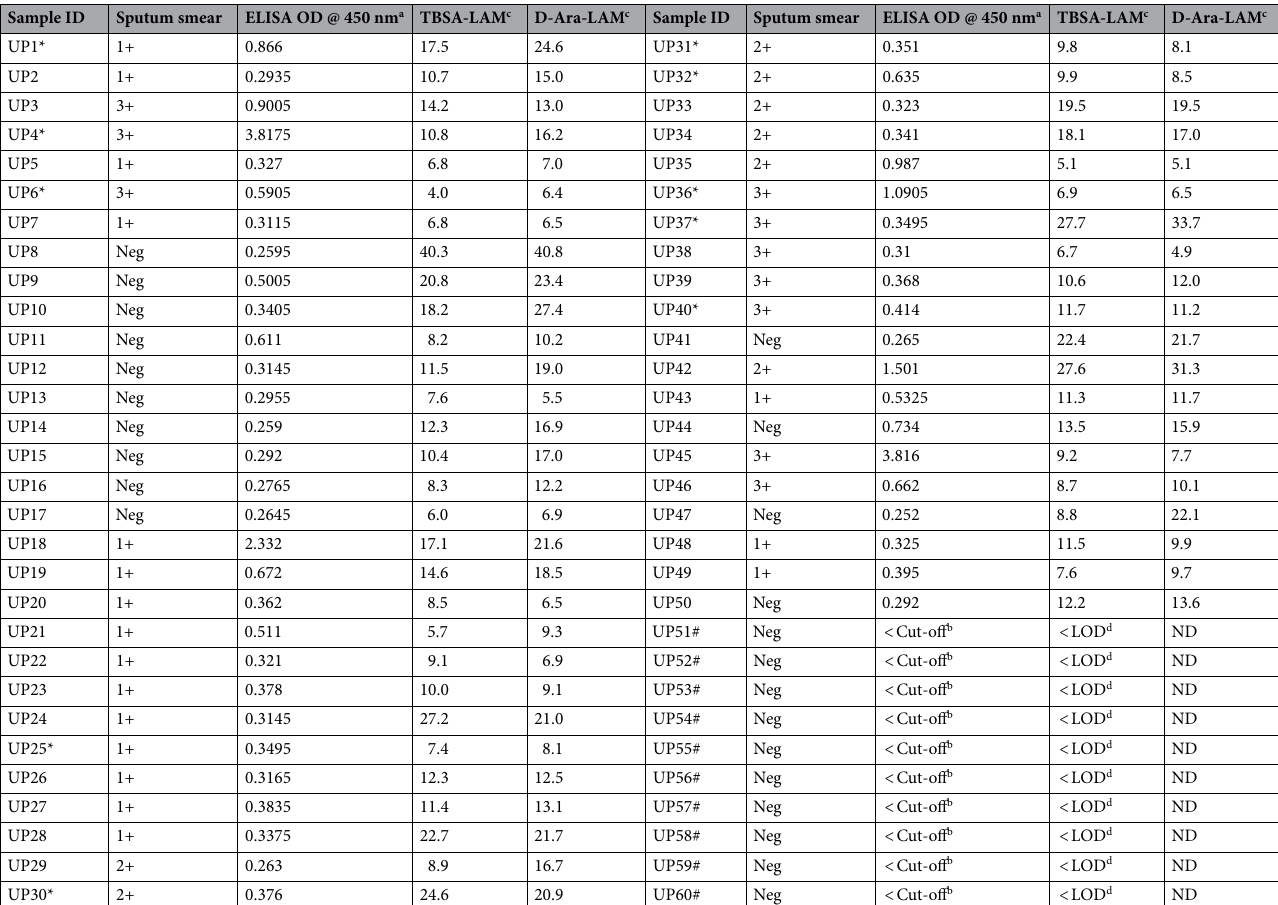
Table 2. Initial cohort of 60 patient’s urine samples from Peru. 50 were sputum culture positive adult TB patients. #10 (UP51-UP60) Culture negative, smear negative pediatric TB negative control from same endemic region. *Only 10 samples were from HIV infected person. a ELISA was done using CS35 as capture